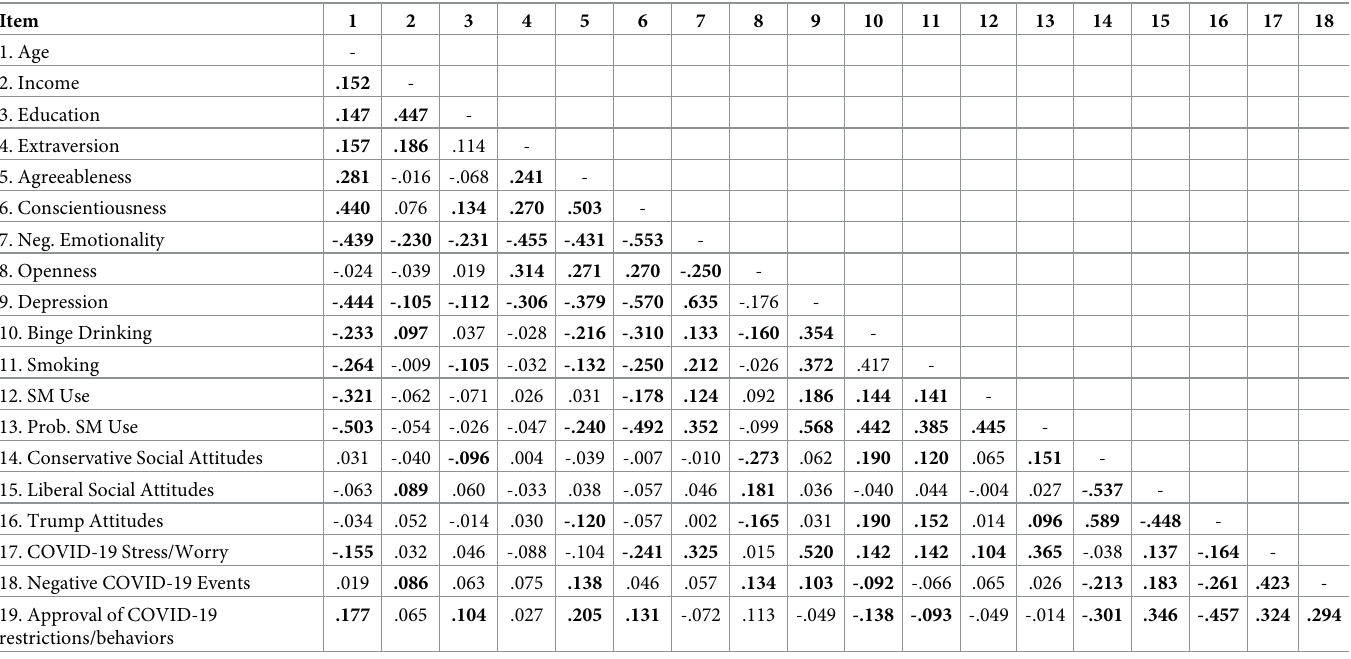
Table 4. Predictor and outcome correlations.